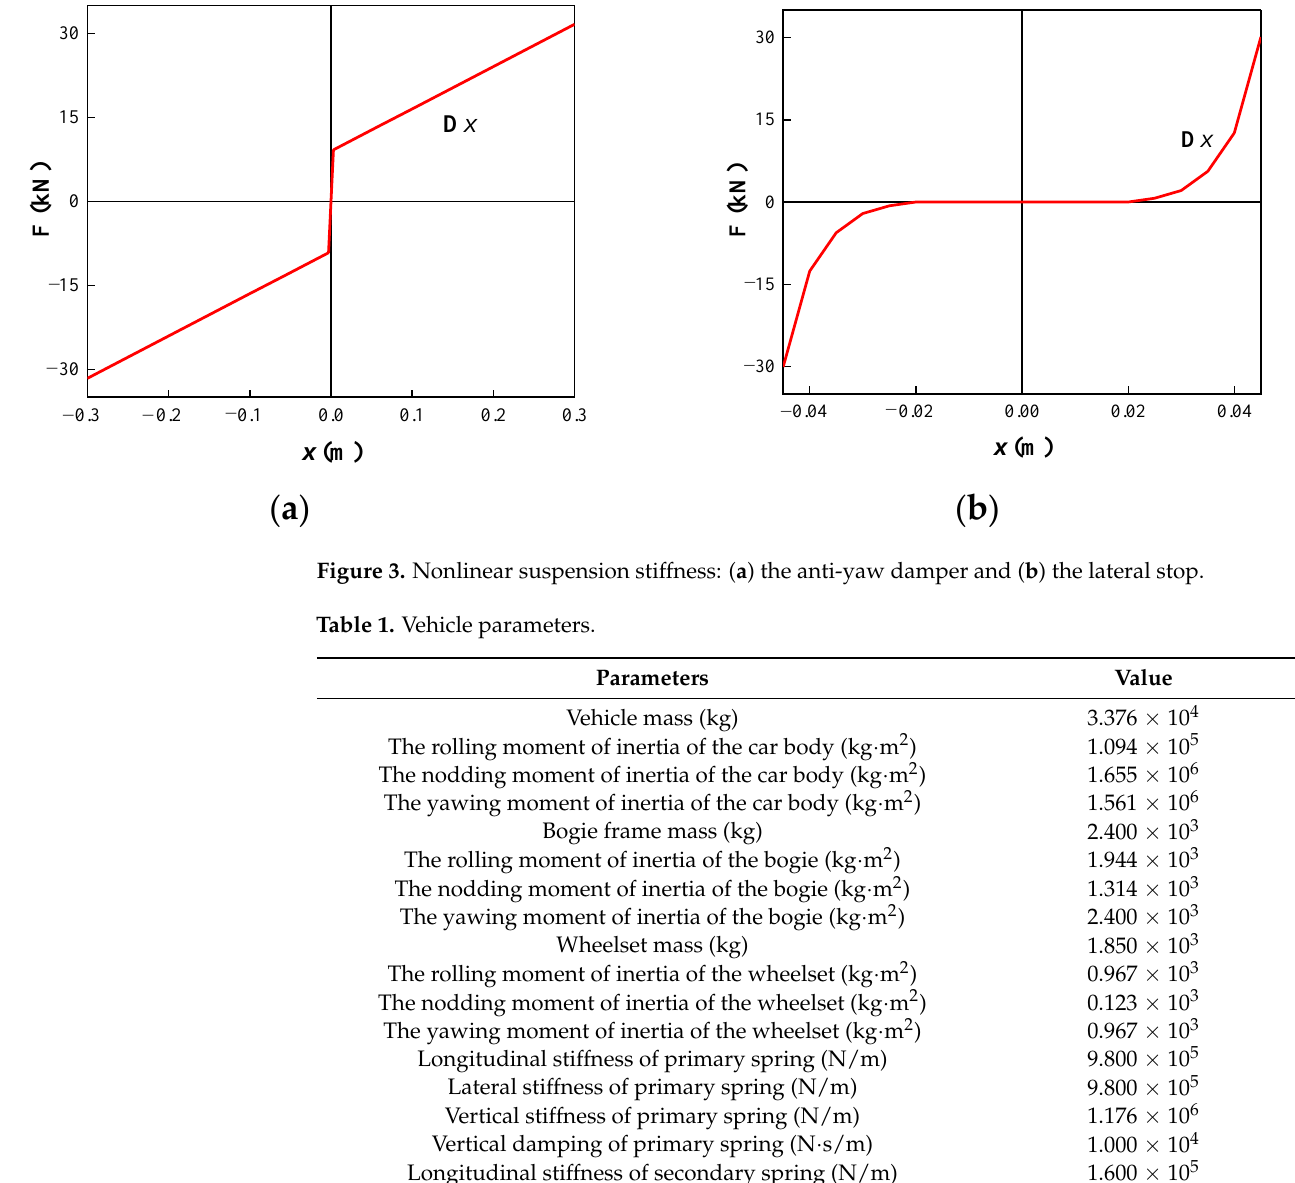
The switch and the stock rails are modeled as two separate bodies, obtained by defining separate sets of wheel-rail pairs. The position and angle of the switch and stock rail in the lateral and longitudinal directions can be set independently, so the relative position between the two rails can be simulated. The stock rail and switch rail models are shown in Figure